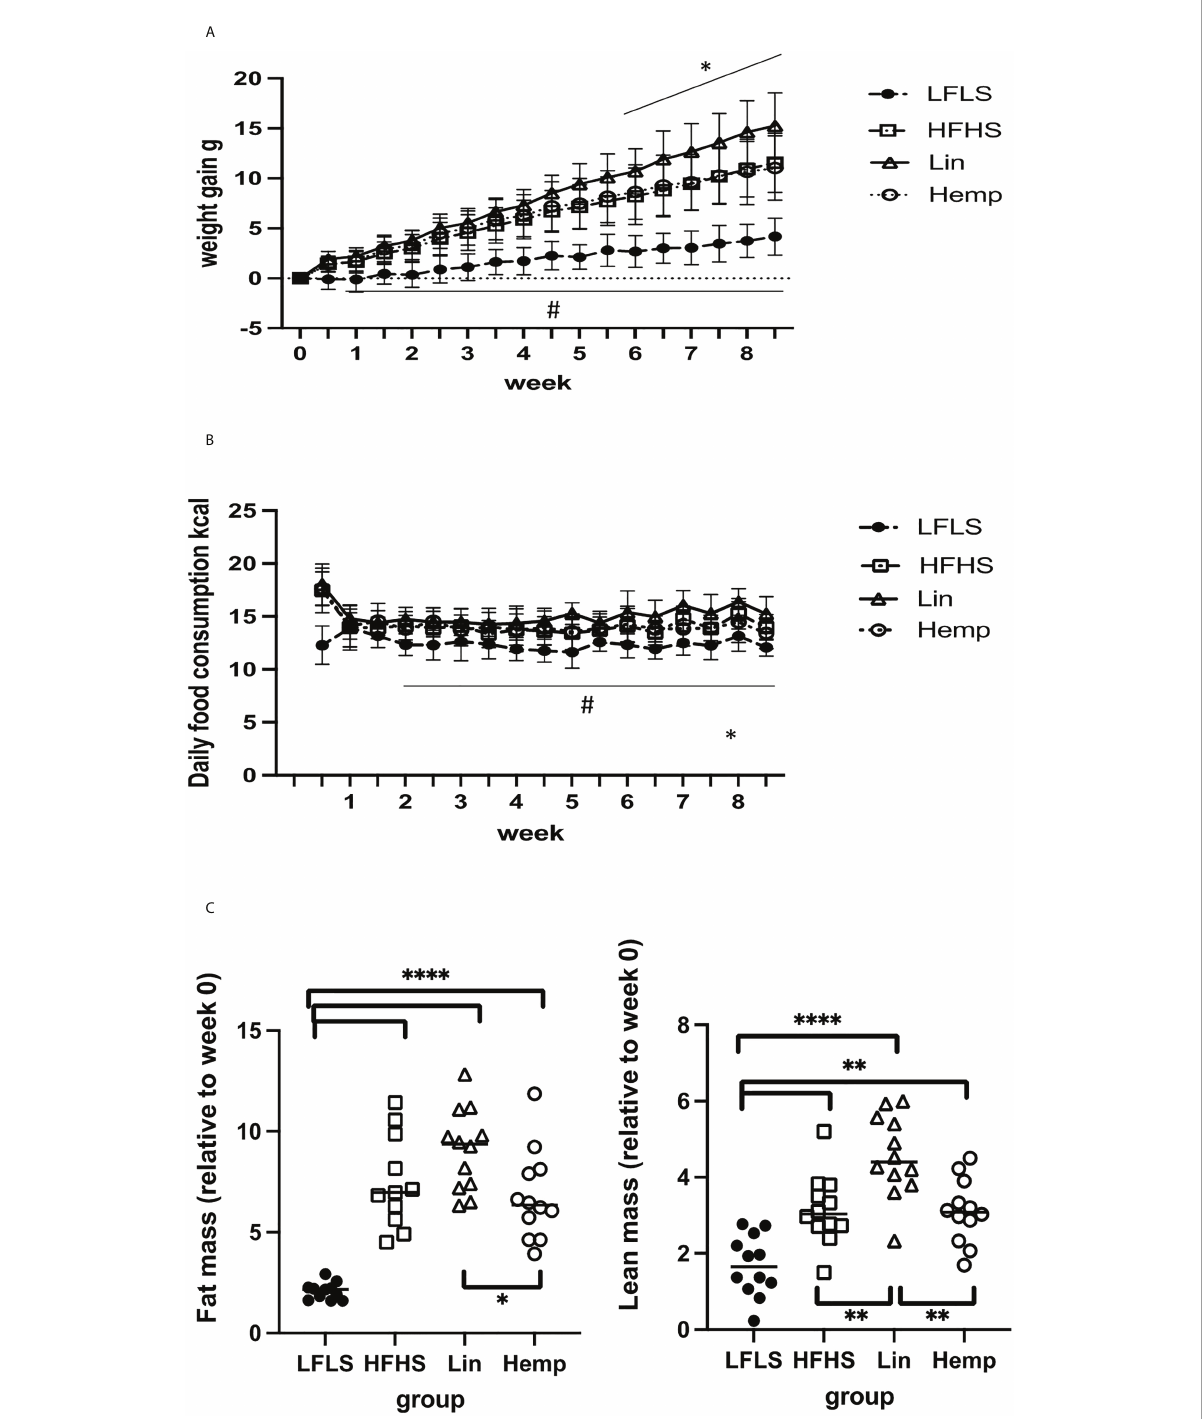
FIGURE 1 Diet-induced changes in weight gain and body composition. (A) Weight gain in g: # signi fi cant difference between LFLS versus all the groups fed with HFHS diet ( p < 0.05); *signi fi cant difference between Lin group versus Hemp and HFHS groups ( p < 0.05). (B) Daily food consumption in Kcal: # signi fi cant difference between LFLS versus all the groups fed with HFHS diet ( p < 0.05). *signi fi cant difference between Lin group versus Hemp group ( p < 0.05). (C) Body composition changes (difference between week 0 and week 8 in g). * p < 0.05; ** p < 0.01; **** p <